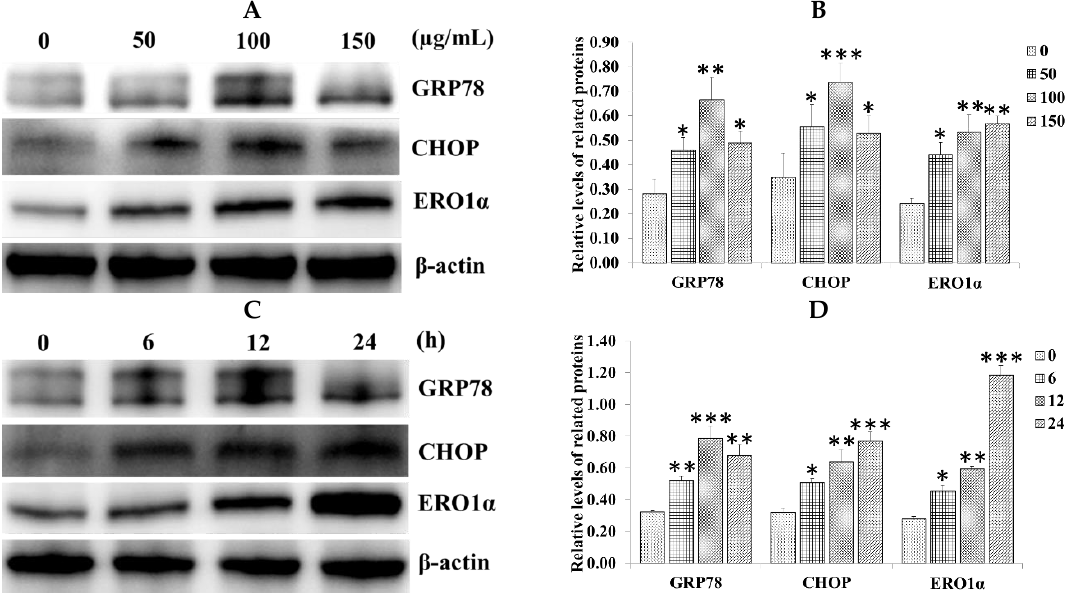
Figure 2. SiNPs induced the expression of the endoplasmic reticulum (ER) stress-related proteins in RAW 264.7 macrophage cells. ( A , B ) The expression of glucose-regulated protein 78 (GRP78), CCAAT/enhancer binding protein homologous protein (CHOP), and ER oxidoreduclin 1α (ERO1α) was analyzed via western blot analysis. Cells were exposed to different concentrations of SiNPs (0, 50, 100, and 150 µg/mL) for 12 h; ( C , D ) Cells were exposed to different times (0, 6, 12, and 24 h) with 100 µg/mL SiNPs. Analyses of the band intensity on the films are presented as the relative ratio of the related proteins to β-actin. Statistical analysis is shown in the bar graphs. Data are presented as the mean ± SDM of three independent experiments. Statistically different from the control is marked with asterisks (* p < 0.05, ** p < 0.01, and *** p < 0.001).